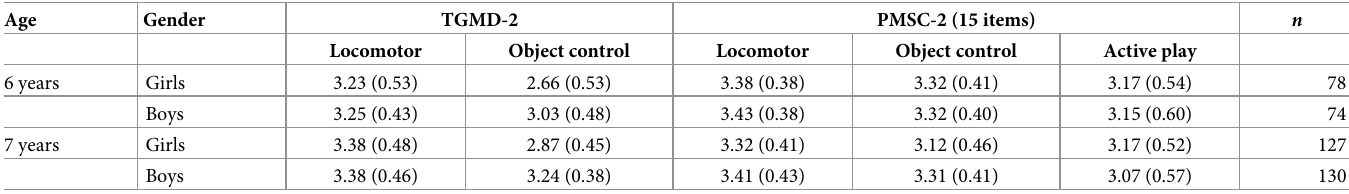
Table 5. Mean (SD) scale scores for the larger sample ( n =